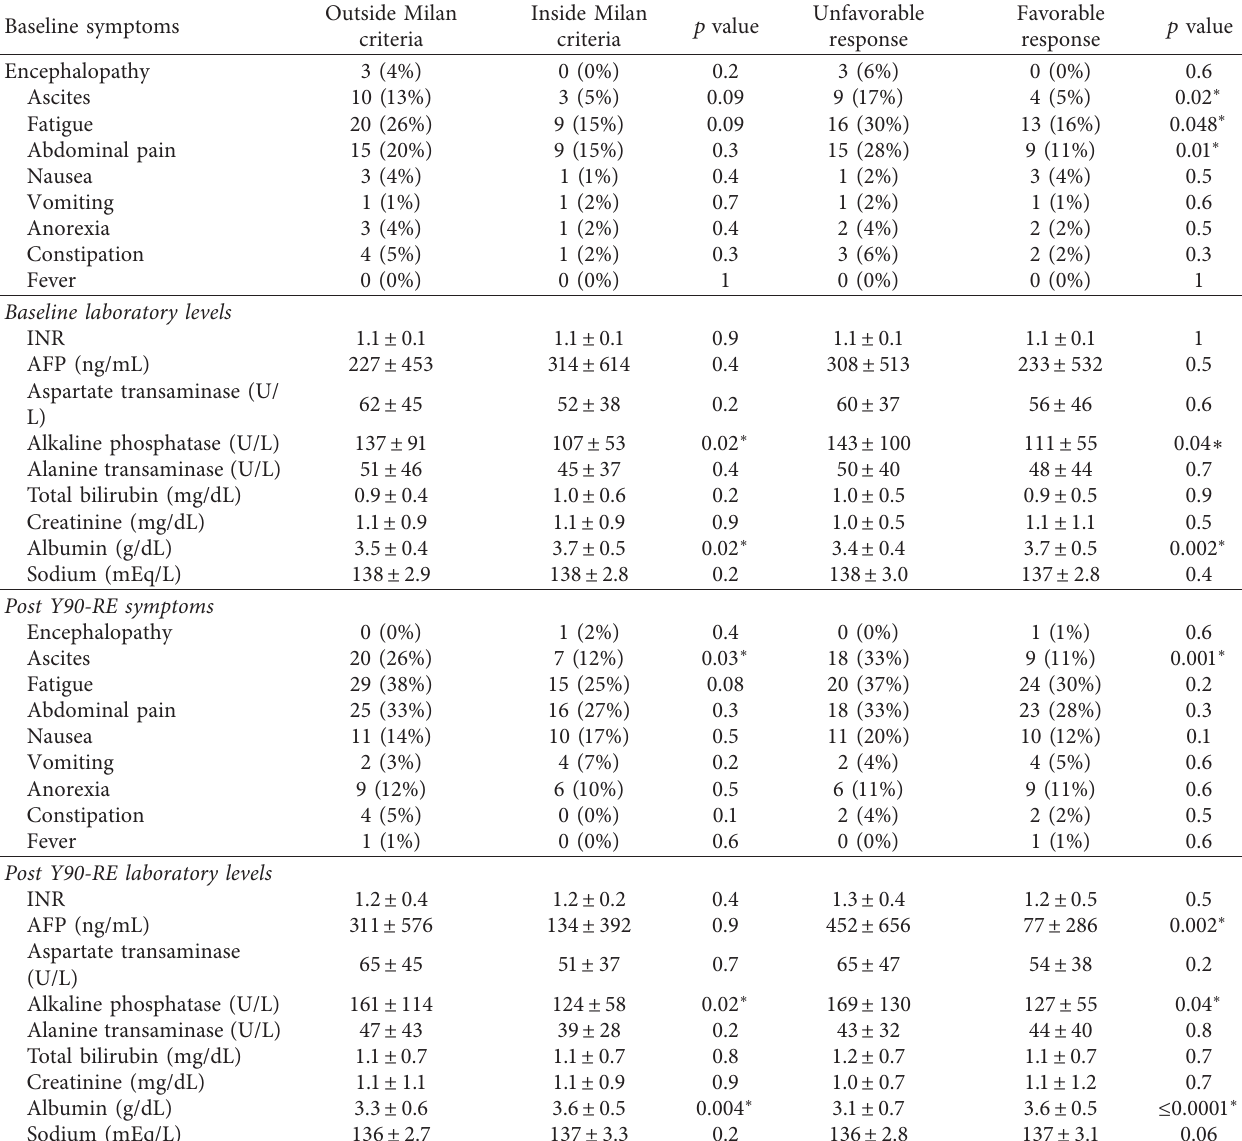
Table 3: Clinical and laboratory